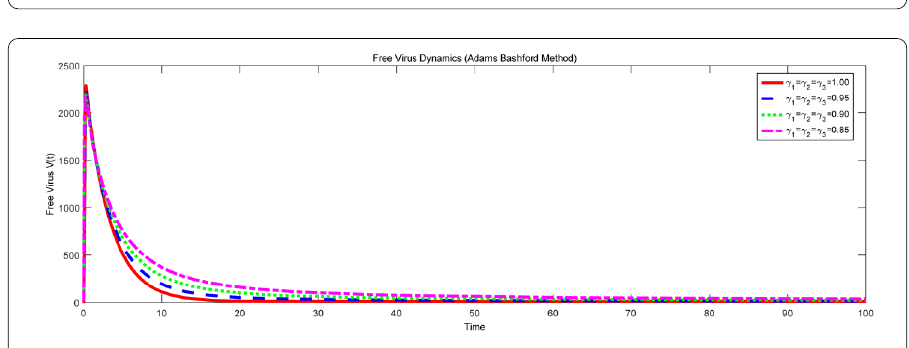
Figure 6 Dynamics of I ( t ) with γ i = 1 (solid red line), γ i = 0.95 (dashed blue line), γ i = 0.9 (dotted green line) and γ i = 0.85 (dotted dashed magenta line), i = 1,2,3.